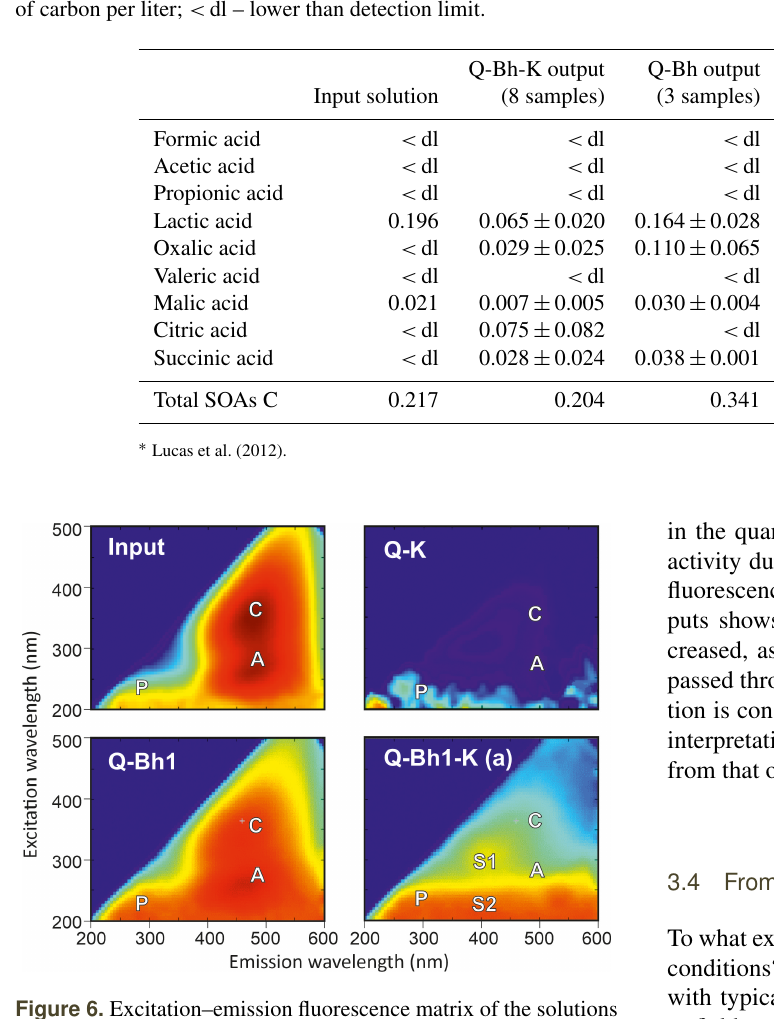
Figure 6. Excitation–emission fluorescence matrix of the solutions and arbitrary units. The letters identify the usual position of the peaks P (protein like), C (humic like), A (fulvic like), S1 and S2 (non-humic or fulvic